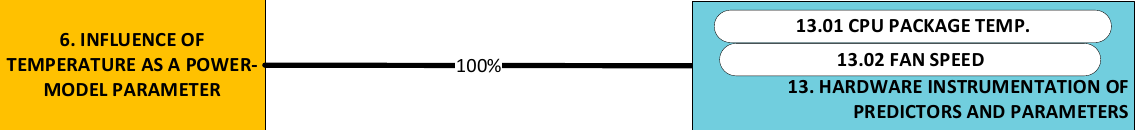
shown in line thickness k shown in line thick- (cid:3169) shown in line thick- (cid:3169)